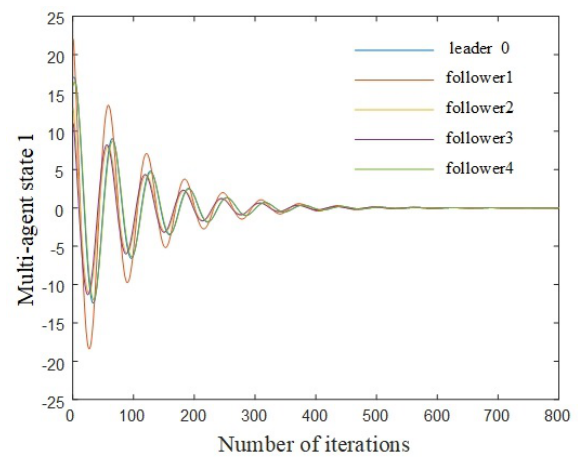
Fig. 8. Three-dimensional coordinate diagram of multi-agent states at finite